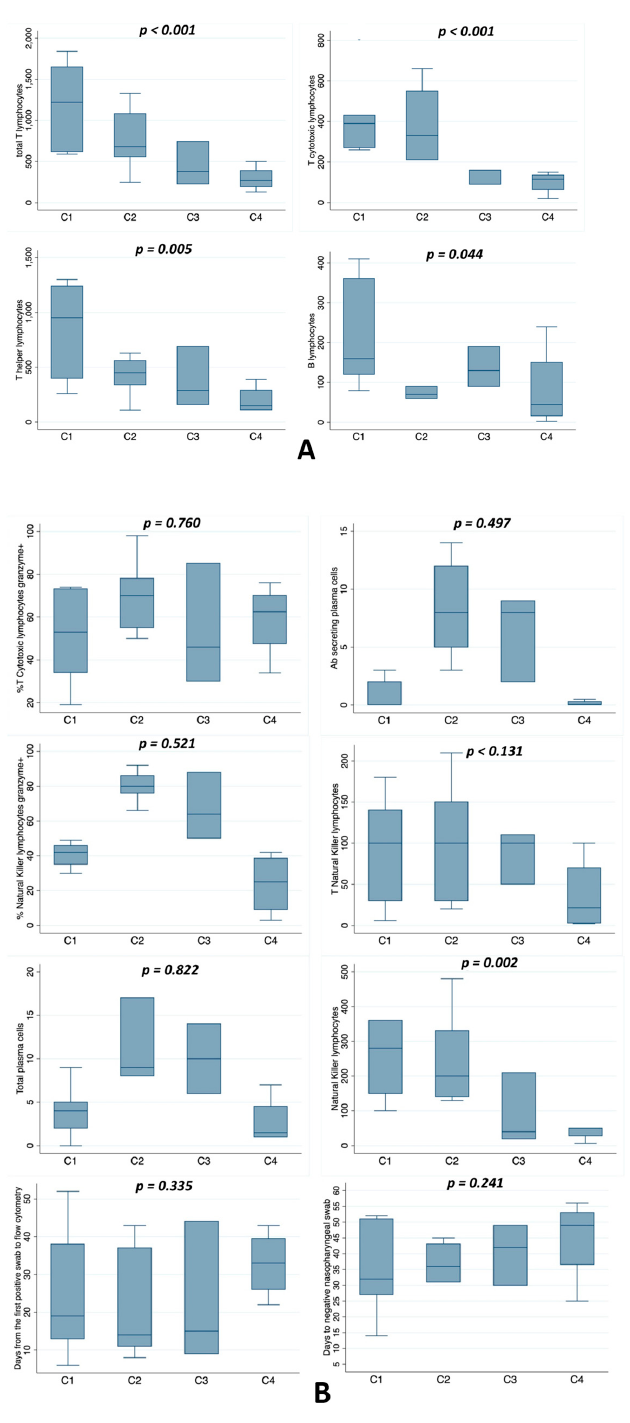
Figure 3. ( A ) Whisker-plot comparison of the four groups according to flow cytometry with a statistically significant trend from the first to the fourth group. The p -value is referenced to indicate the presence or absence of a significant trend among the four groups. ( B ) Whisker-plot comparison of the four groups according to variables without a statistically significant trend from the first to the fourth group. The p -value is referenced to indicate the presence or absence of a significant trend among the four